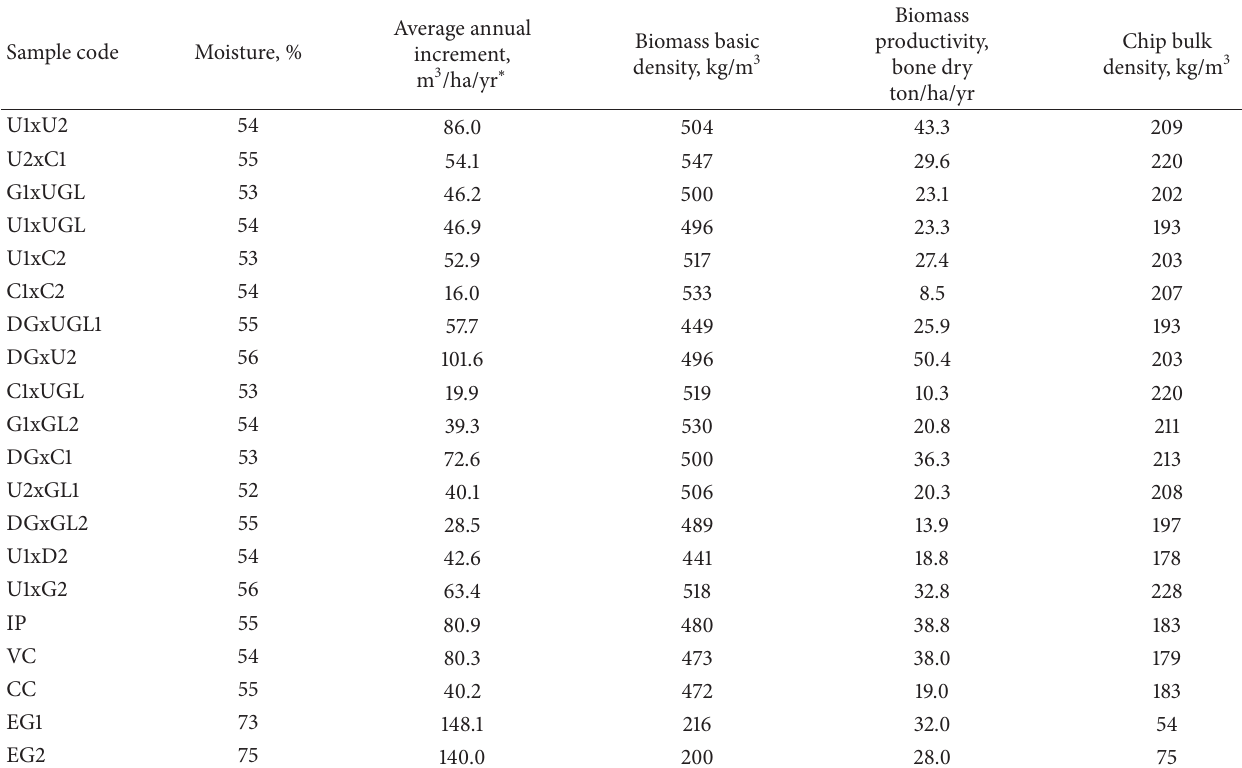
Table 2: Forestry and physical characteristics of the eucalypt clones and elephant grass species evaluated.